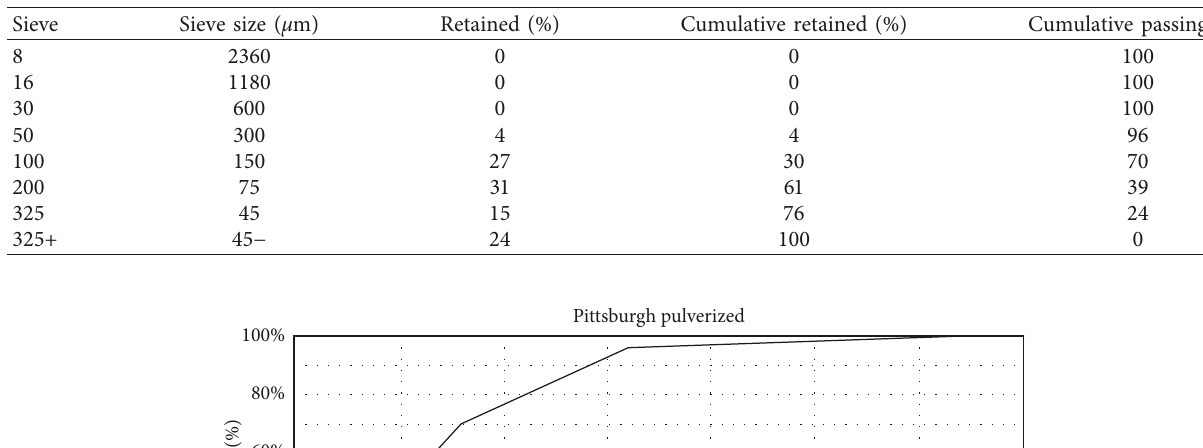
Table 1: Sieve analysis of the Pittsburgh pulverized sample [8].